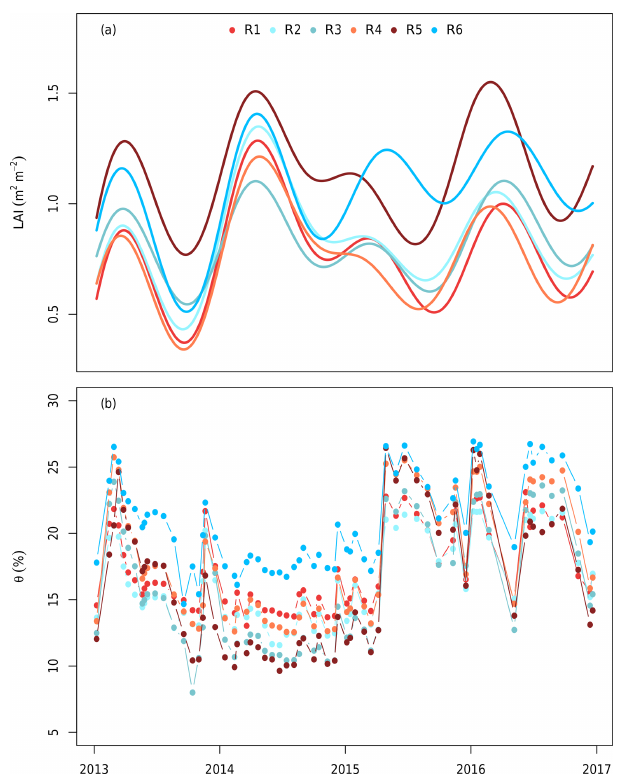
Figure 2. (a) The leaf area index (LAI) and (b) soil volumetric wa- ter content ( θ ) used to drive the model. The LAI was estimated in each ring from measurements of understorey PAR and smoothed us- ing a generalized additive model following Duursma et al. (2016). θ was measured using neutron probes in the top 150cm biweekly (Gi- meno et al., 2018). Each line colour indicates a different plot. Red shows elevated CO 2 plots (treatment), whereas blue shows ambient CO 2 plots (control). The x axis ticks mark the start of each year.